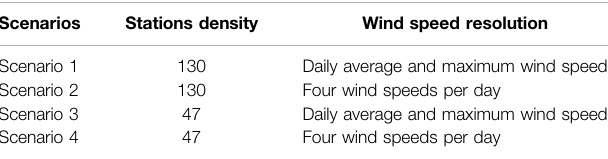
TABLE 2 | The spatial resolution of the climatological stations and temporal resolution of the wind speed for different scenarios.